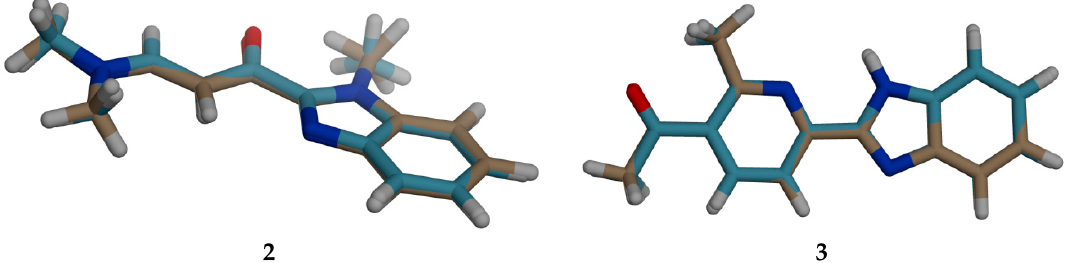
Figure 6. Overlay of the optimized and calculated structures for the studied organic compounds.